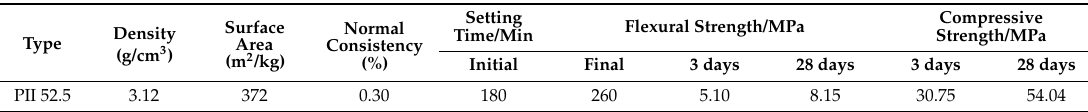
Table 2. Physical properties of Portland cement.